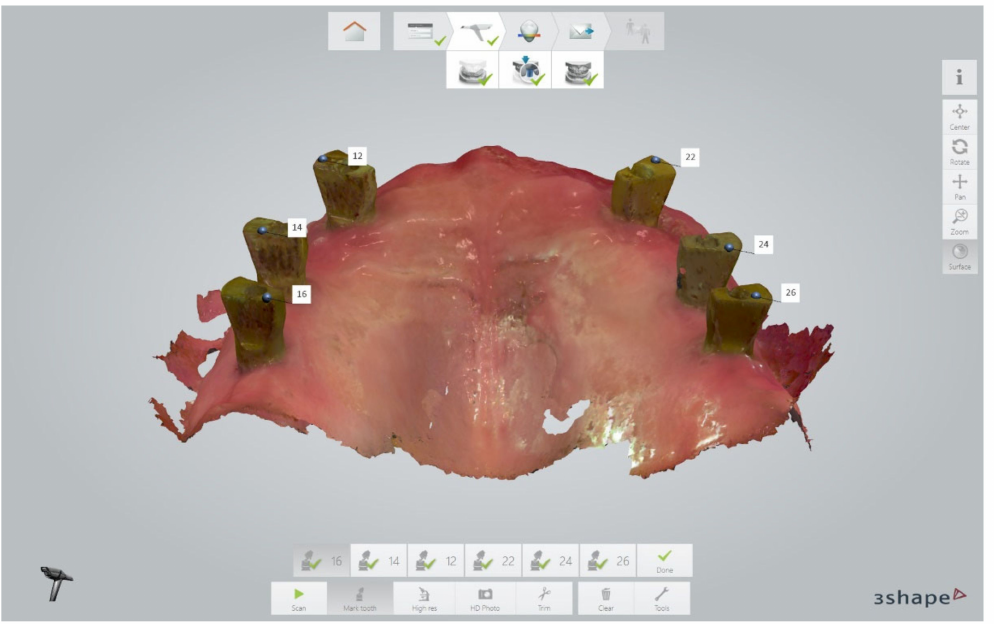
Figure 6. Intraoral scan of the maxillary arch with the scan parts of the dual-function scan bodies during the second scan session (3Shape Dental Desktop 1.7.9.1, 3Shape, Copenhagen, Denmark).